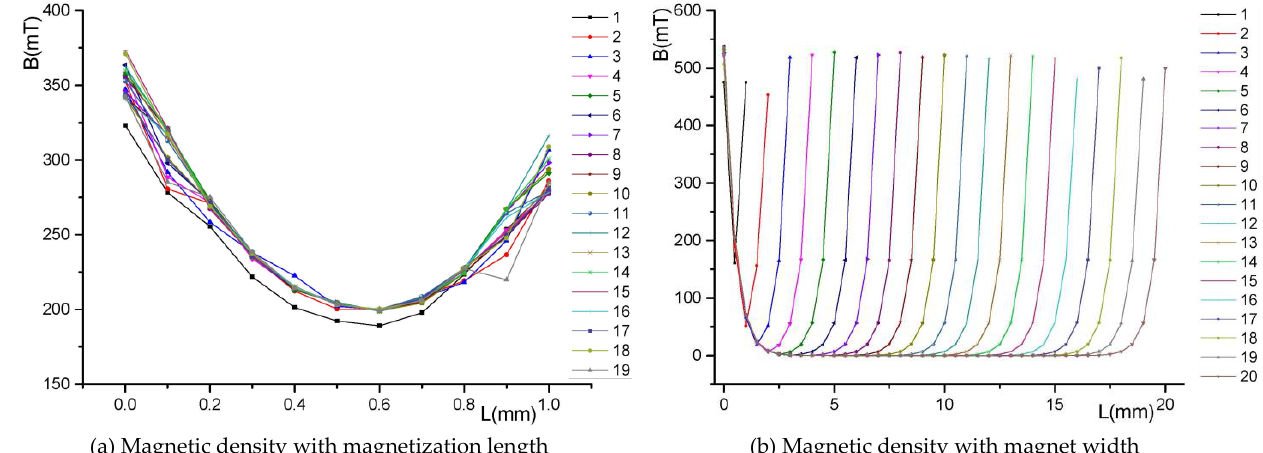
Figure 11. Relationship between the magnetic density and the size of the permanent magnet.